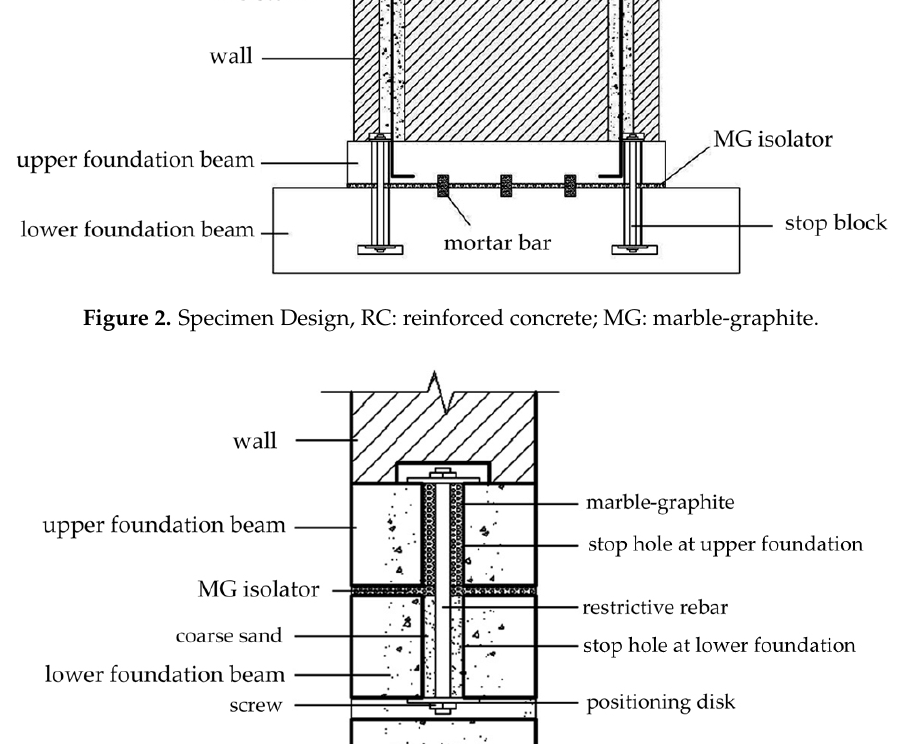
Figure 3. Configuration of the Stop Block.